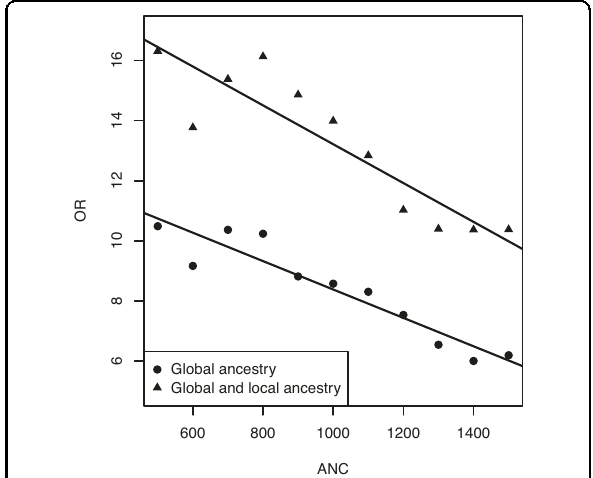
Fig. 2 Odds ratio estimates for varying ANC thresholds (500 – 1500). Odds ratios were determined in association analyses of European individuals corrected for global (principal components PC1 – PC7) and additionally for local ancestry (dosage estimates for ancestral populations AFR and EAS). Regression lines were determined by weighted least squares regression where the reciprocals of the standard errors were used as